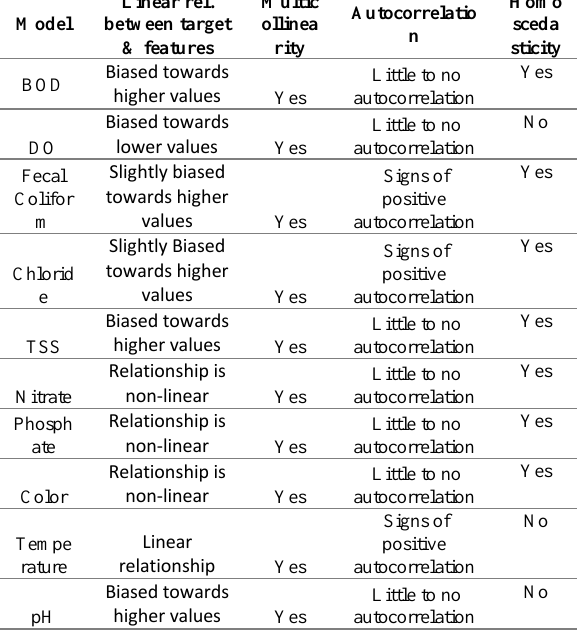
Table 3 . Summarized test results for water quality models Based from the tests, the ones with the most linear relationship between target and features are the temperature (linear), Fecal Coliform (slightly biased), and Chloride (slightly biased), this means that all other models might indicate underfitting. All models failed the multicollinearity test, which becomes a problem since it adds to the overall standard errors to its predictions. Signs of positive autocorrelation appears on the Fecal Coliform, Chloride, and temperature models, which can impact model estimates. The test for homoscedasticity failed for DO, Temperature and pH